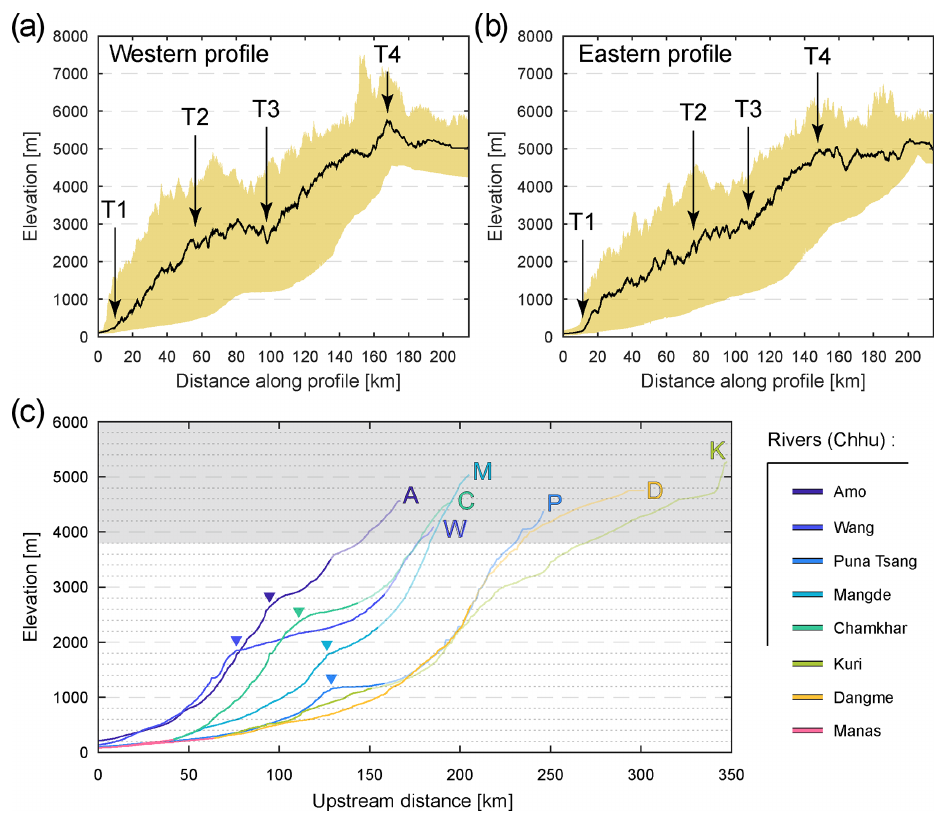
Figure 2. Topographic and longitudinal river profiles. (a,b) Swath topographic profiles across the western (a) and eastern (b) Bhutan Himalaya over a 100km wide region, from the Gangetic Plain up to the southern Tibetan Plateau. Location of the swaths is reported in Fig. 1b. The colored area encompasses the whole range of altitude values, while the black line draws the median altitude across the profiles. Major physiographic transitions, labeled T1 to T4, are also reported. (c) Longitudinal profiles of major and large rivers in Bhutan, illustrating the variety of river profiles. Rivers are located on the maps of Fig. 1 and are here color-coded and labeled. Major knickpoints are also pointed by triangles. Regions with altitudes above 3800m (grey area) are not to be compared directly to the downstream sections, as these may have a glacial imprint. Portions of the rivers north of physiographic transition T3 are reported by transparent segments. A: Amo Chhu; M: